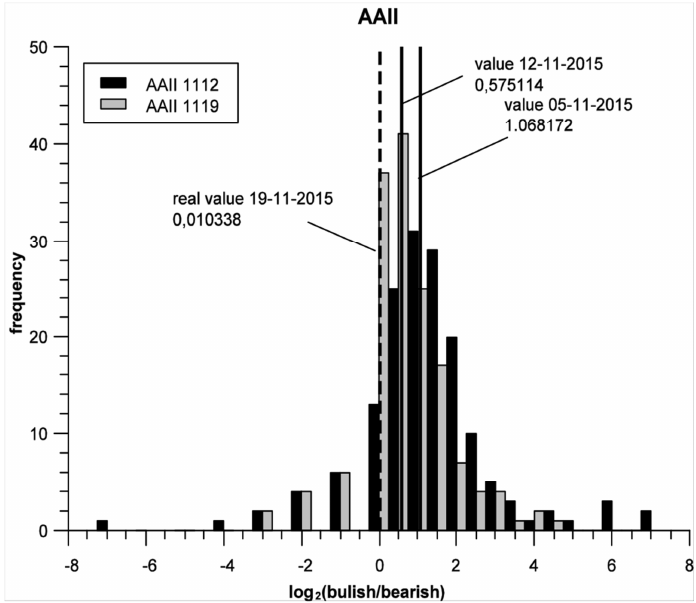
Figure 6. Prediction of individual investors’ sentiments (AAII)